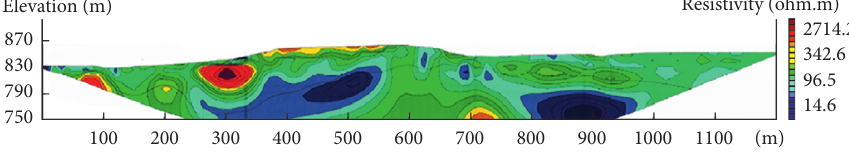
Figure 20: Test line of GMD01.